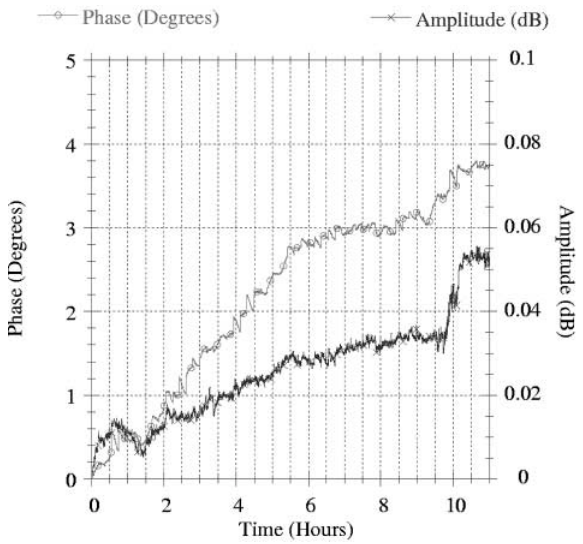
FIG. 5. Stability of measurements over